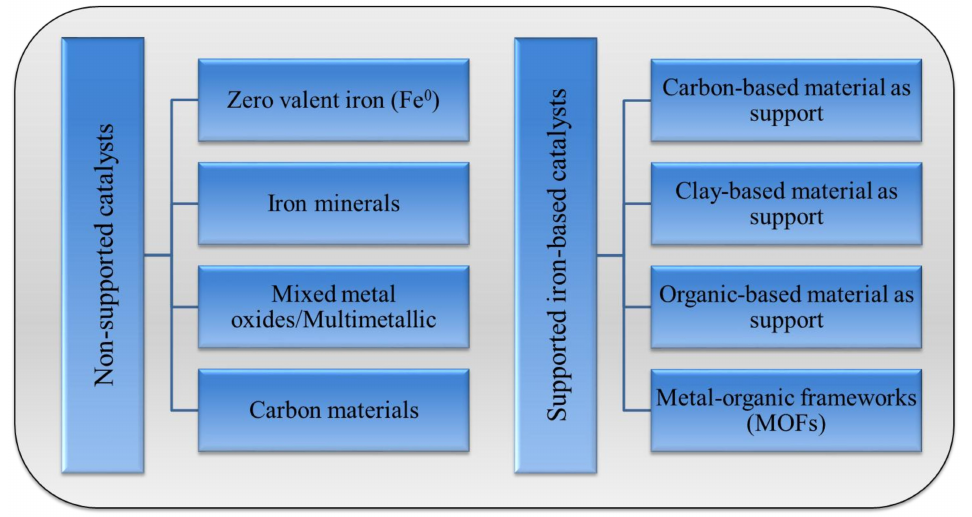
Figure 2. Classification of catalysts used for catalytic wet peroxide oxidation